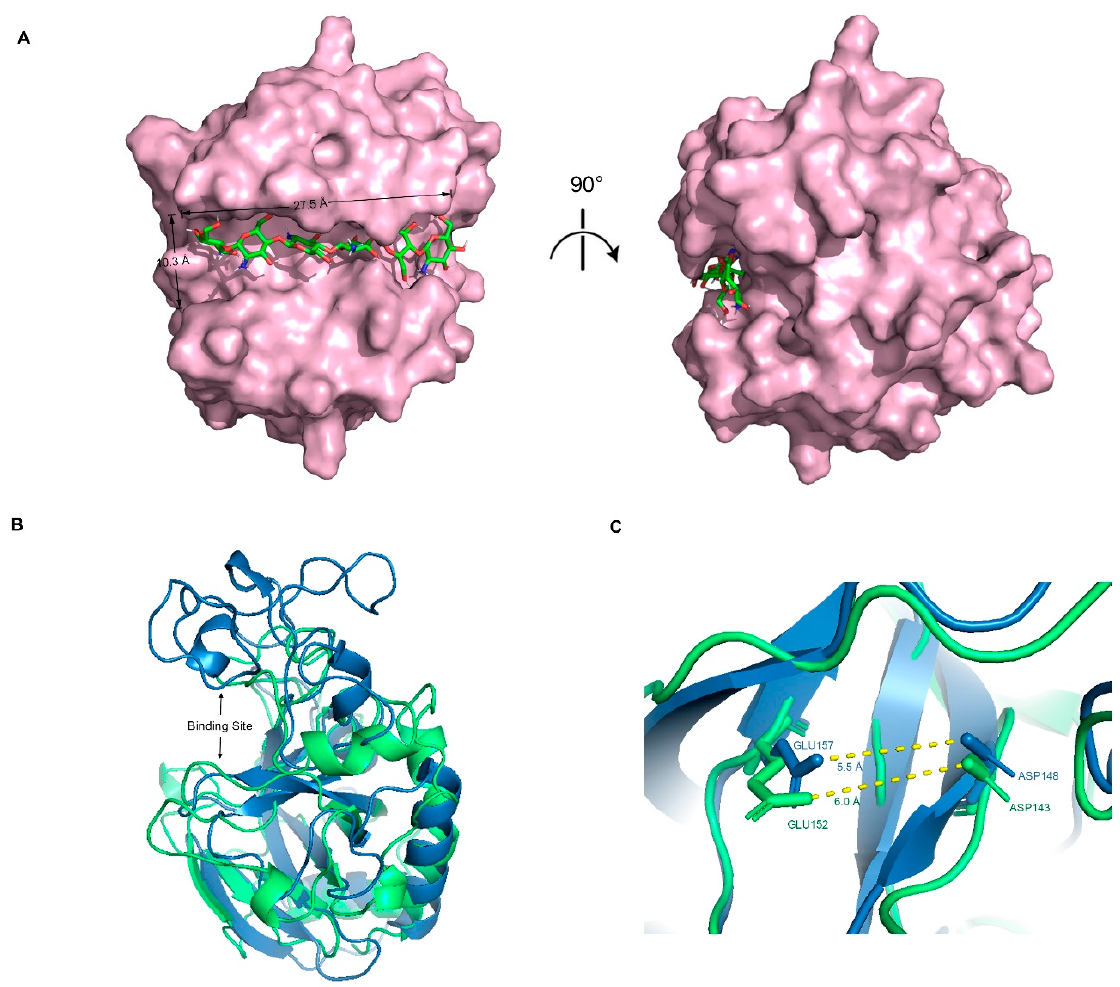
Figure 3. ( A ) Complex conformation after molecular docking, where the chitosanase is shown by the surface and the DP6-chitosan is shown by the stick, and the view of the right side was rotated 90 ◦ to show the side view. ( B ) Q875I9 was structurally aligned with V-Csn by Pymol (green represents Q875I9 and blue represents V-Csn). ( C ) Magnified display of the relative position of two catalytic residues in both two chitosanases, respectively, and the yellow dashed lines represent the linear distance between the respective catalytic residues.